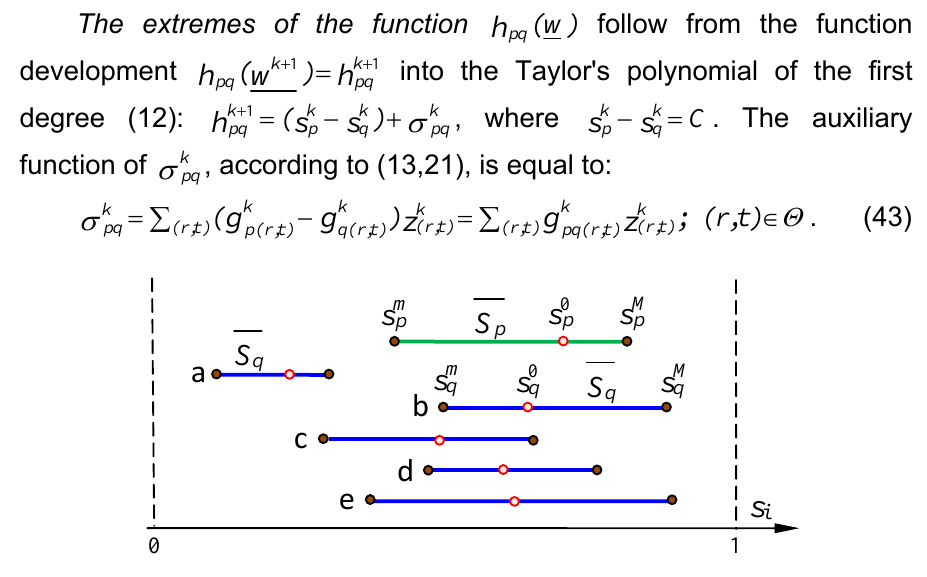
of two variants i двух i